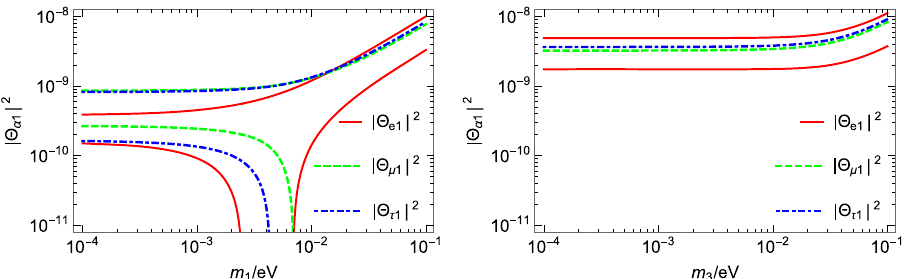
Fig. 1 Themaximallyandminimallyallowedvaluesof | (cid:16) α 1 | 2 asfunc- tions of the lightest neutrino mass in the NO (left) and IO (right) cases. These results are obtained by taking M 1 = 10 MeV and the best-fit